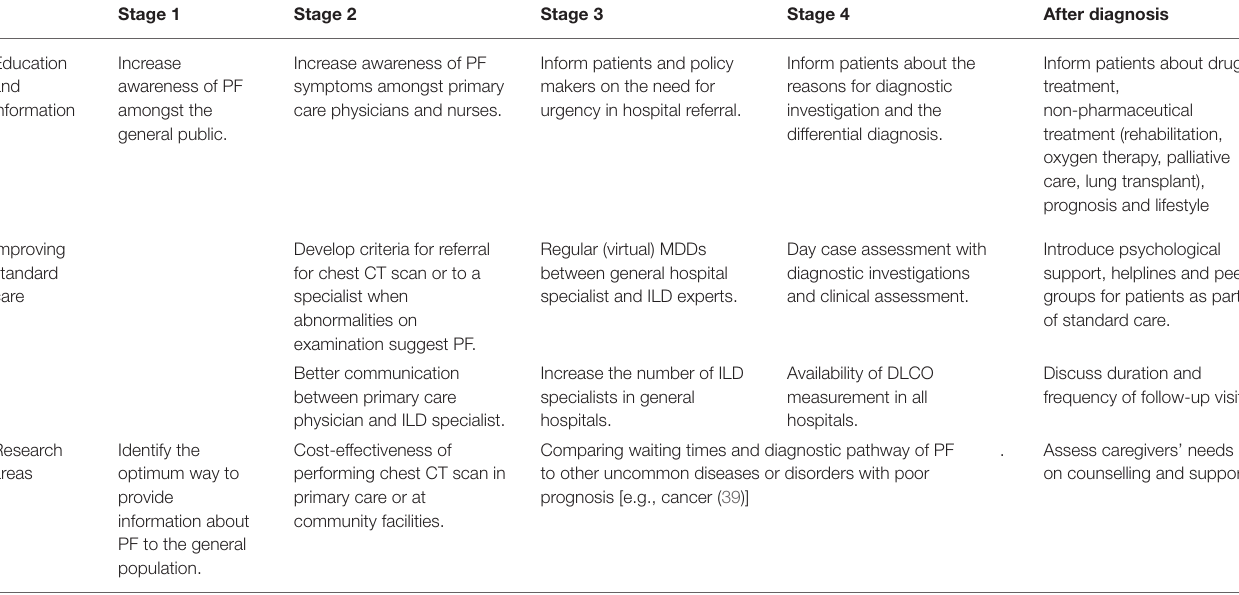
TABLE 2 | Strategies for improving the diagnostic pathway of pulmonary fibrosis